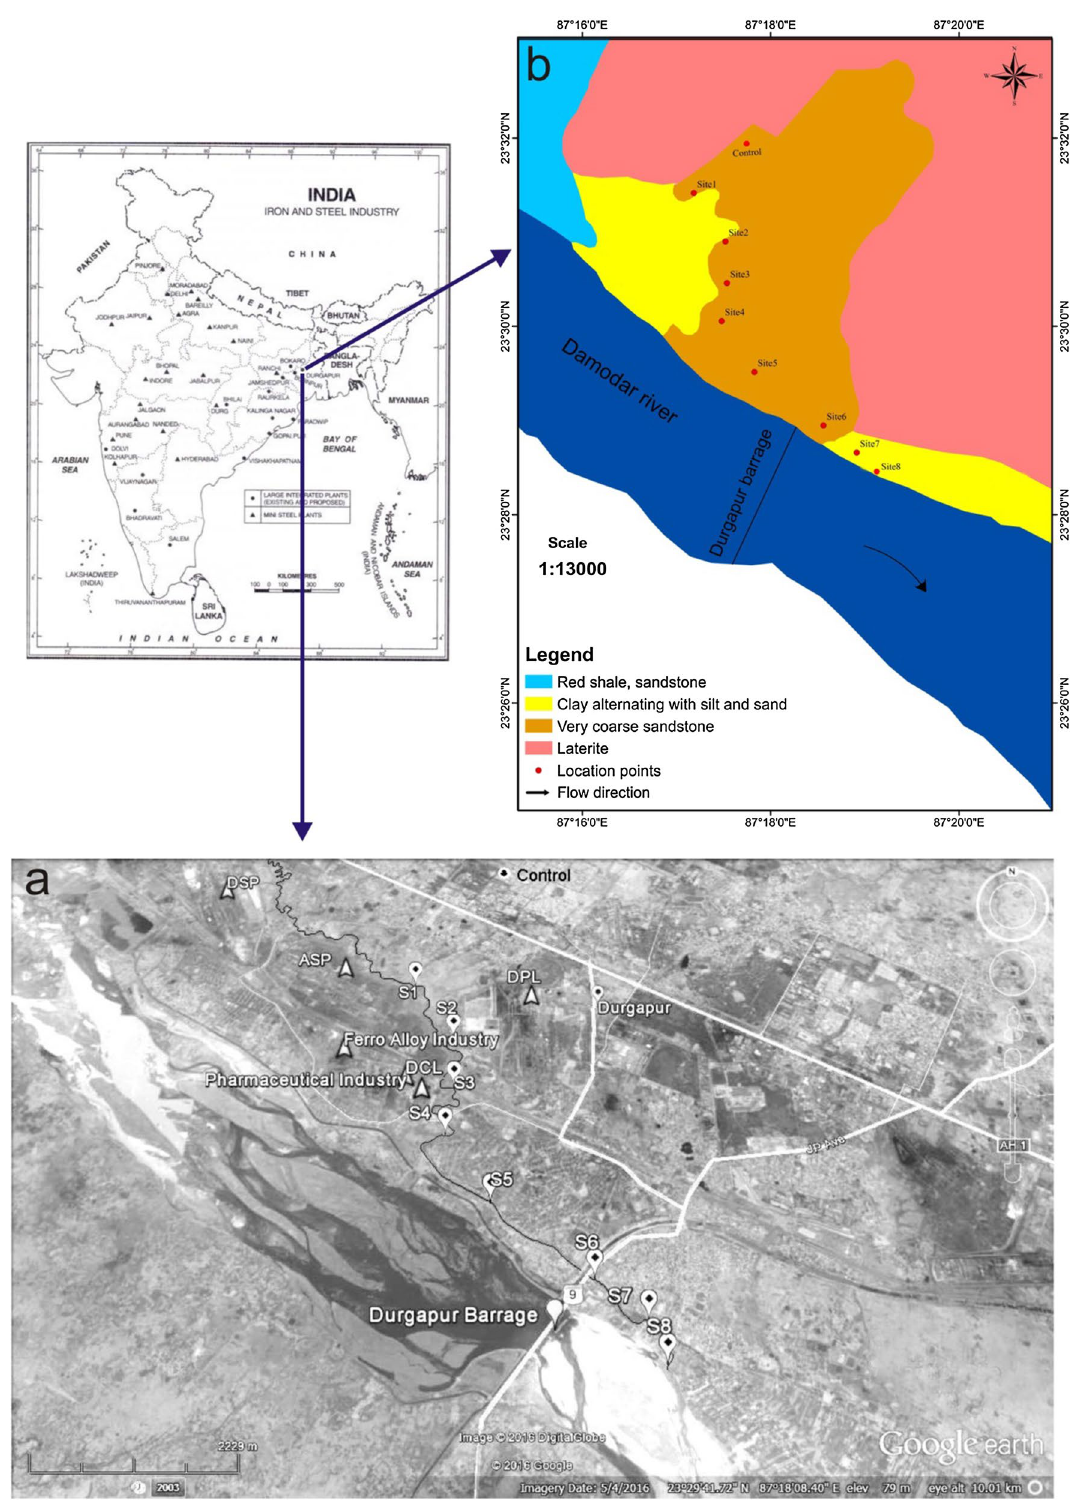
Fig. 1 Location of sampling sites ( a ) and regional geology ( b ) of the study